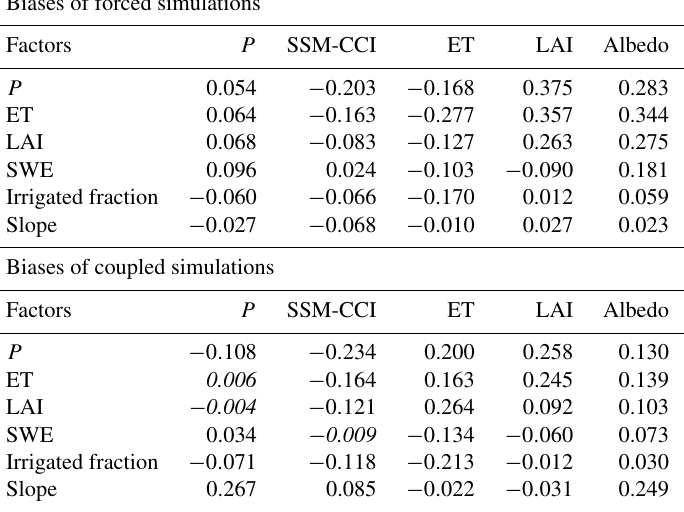
Table 4. Spatial correlation coefficients (SCCs) between biases (in forced and coupled modes) and potential explanatory factors. PFT was excluded here because it is on a nominal scale. Statistically insignificant SCCs appear in italics. SSM tended to be underestimated in high P , SSM, ET, and LAI regions for both forced and coupled modes. Between forced and coupled ET, an opposite association with P , ET, and LAI was observed. LAI in both modes was positively biased in high P , ET, and SSM regions (probably corresponding to the tropical region). Albedo and coupled P were strongly associated with slope. Irrigation is likely to bias SSM and ET negatively, and the effect was more enhanced in the coupled